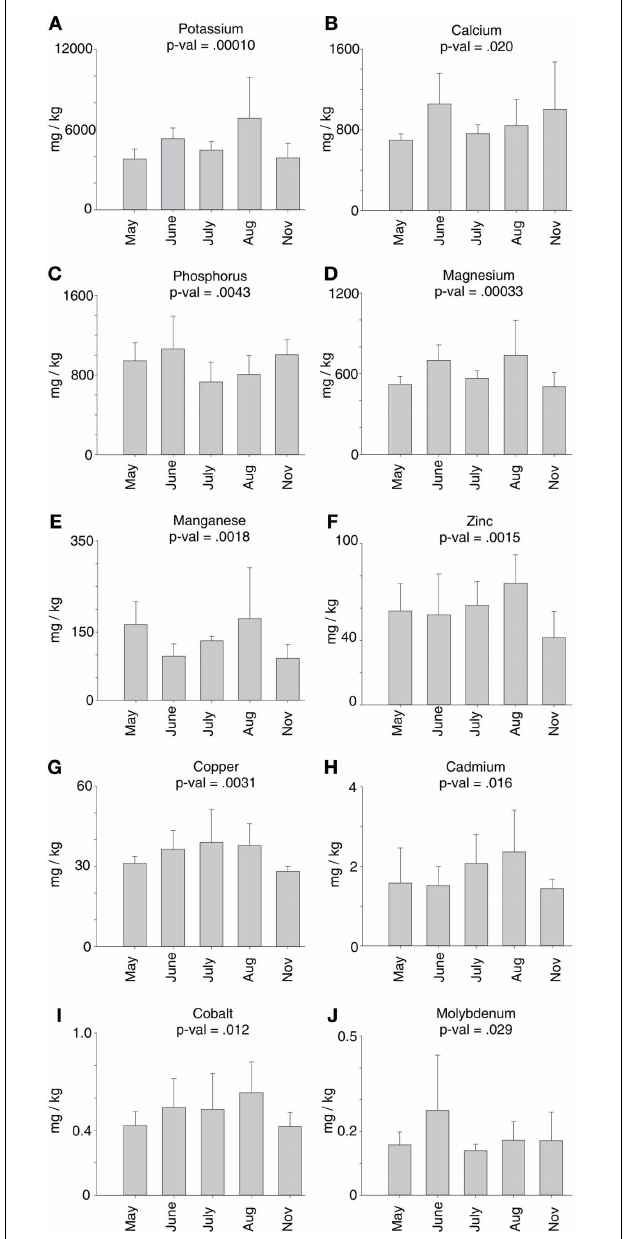
FIGURE 8 | Mineral concentrations in crowns and rhizomes of field grown cv Summer plants across harvest dates. Each panel shows the change in mineral concentration for a specific mineral. Analysis for each time point consisted of two technical replicates from each of three biological replicates ( n = 6). Average abundances with standard deviation error bars are shown in this figure. P -values were calculated for each mineral using Single-Factor ANOVA. (A) Potassium; (B) Calcium; (C) Phosphorus; (D) Magnesium; (E) Manganese; (F) Zinc; (G) Copper; (H) Cadmium; (I) Cobalt; (J)